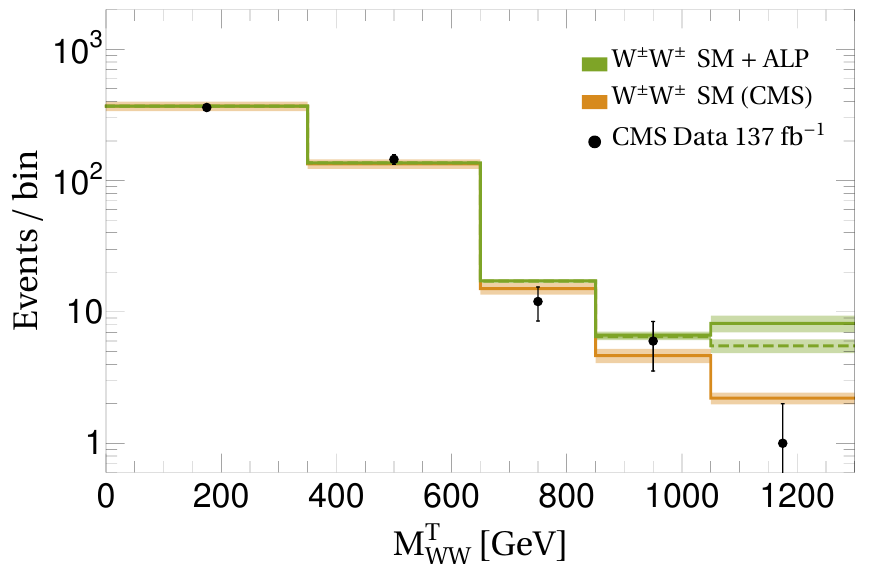
Figure 11 . M T distribution for the pp → jjW ± W ± → jj‘ ± ‘ ± νν channel. The data points WW and the total SM background (orange) are taken from the measurement in ref. [50]. The last bin contains the overflow events. The dashed and solid green lines show the total ALP EW VBS signal for c /f a = c /f a = 1 TeV − 1 with a cut of M WW < 2 TeV and 4 TeV , e B e W